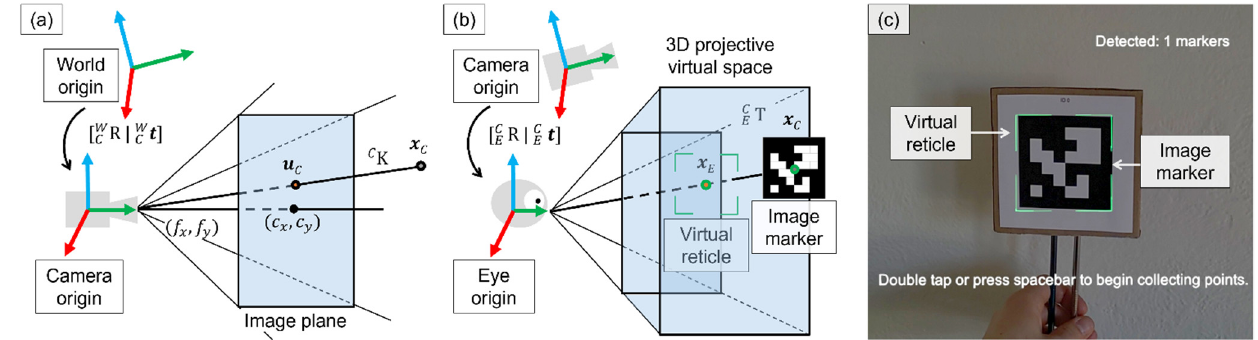
Figure 2. ( a ) Pinhole camera model (perspective projection) to relate 3D world points 𝒙 (cid:3030) to their 2D image projections 𝒖 (cid:3004) by the intrinsic matrix K (cid:3004) . Focal lengths length 𝑓 (cid:3051) and 𝑓 (cid:3052) are the distance between the pinhole and the image plane. Principal points are indicated as 𝑐 (cid:3051) and 𝑐 (cid:3052) [27] . ( b ) Physical viewing frustum (user perspective). A 3D rigid transform 𝑇 (cid:3006)(cid:3004) is computed to relate 3D head-relative points of tracked content in the camera coordinate system 𝒙 (cid:3030) to 3D viewpoints within the display of the HMD 𝒙 (cid:3006) [27]. ( c ) Image captured through the head-mounted display during the display calibration procedure. The user is tasked with alignment of the tracked image marker (with centroid 𝒙 (cid:3004) ) with the virtual on-screen reticle (with centroid 𝒙 (cid:3006) ).